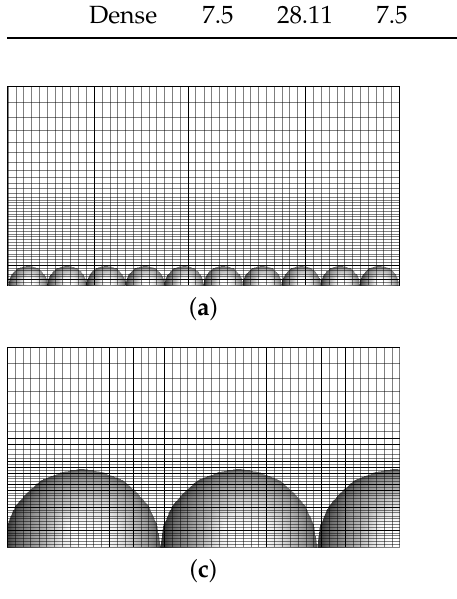
Figure 4. Computational meshes in the vicinity of the spheres for the configurations S0.5 ( a ), S1.0 with the mesh used for the computations using the ANSYS Fluent code ( b ) and S2.0 ( c